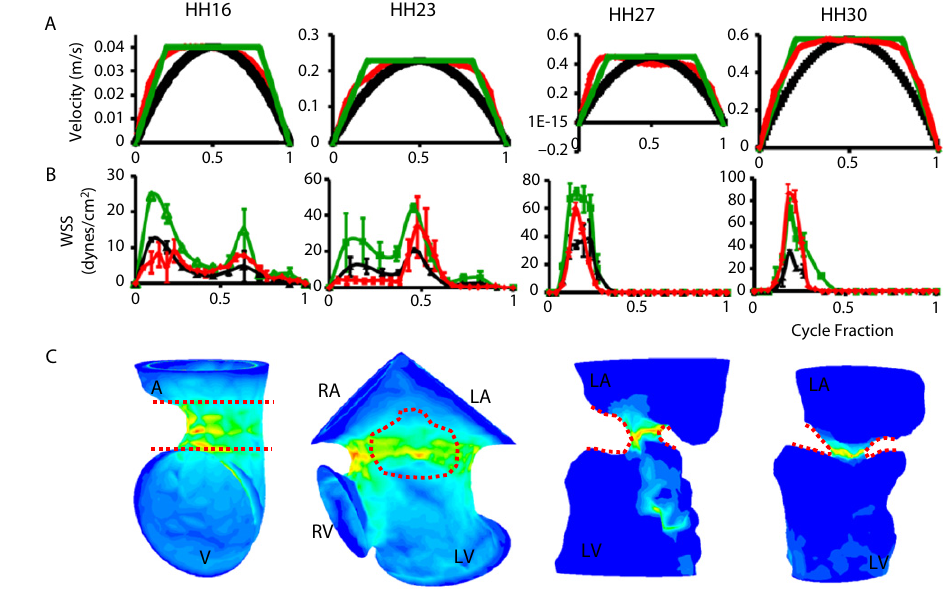
Figure. 4 Hemodynamic changes in valvulogenesis. (A) peak velocity profiles (B) spatially averaged wall shear stress profiles. Red profiles correspond to flow and wall shear stress as calculated by computational fluid dynamics, black refers to the poiseuille profile and green plug flow (boundary layer is taken to be one-fifth diameter). (C) transvalvular shear stress quantifications calculated by computational fluid dynamics. High magnitudes of shear stress correspond to red; low magnitudes, blue. Adapted from